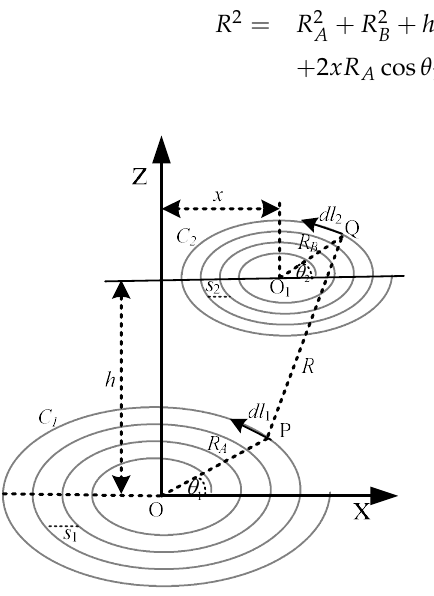
Figure 1. ( a ) Planar spiral coil. ( b ) Aligned circular spiral coil.